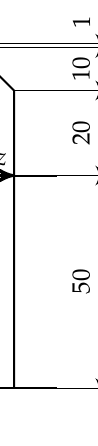
Figure 5. Dimensions of the nozzle of the GF25 pilot-scale plant.